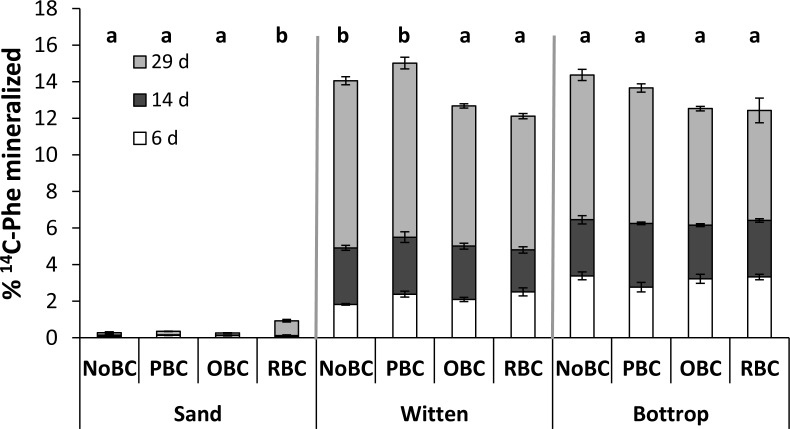
Mineralisation of Phe (as % of the initial Phe in each sample) in sand and soils with different biochar treatment.Non-amended (NoBC) samples (S, sand; W, Witten soil; B, Bottrop soil) and samples amended by 1% (w/w) pine woodchips-derived biochar (PBC), olive pruning-derived biochar (OBC) and rice biochar (RBC). Soils were spiked with Phe at a dose 1 m g Phe g soil and incubated during 29 days. The results are presented as means ± SE (n = 3). The different letters denote significant differences (p < 0.05) between means.